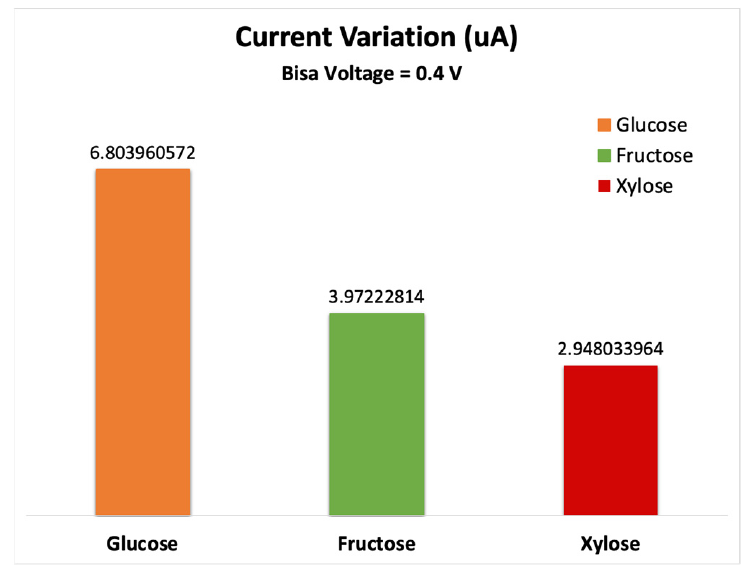
Figure 9. Variation in electrical drain current for the various types of sugar molecules.